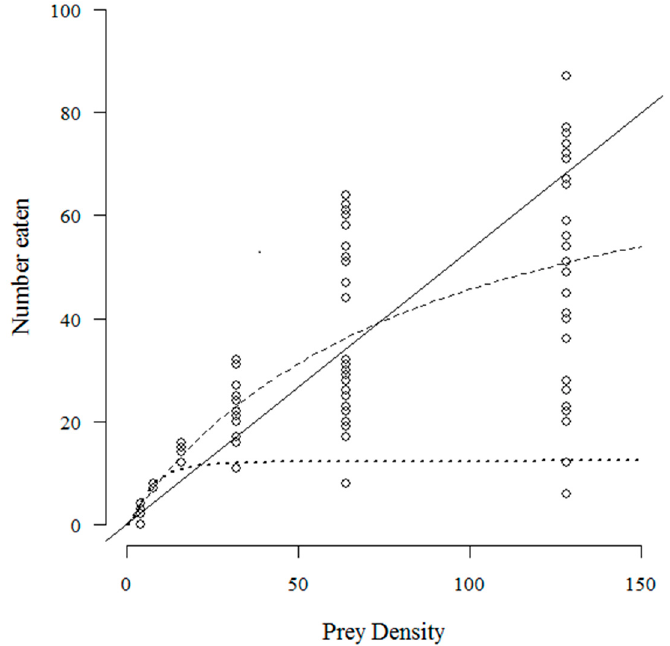
Figure 1. Number of T. absoluta eggs eaten during 24 h by the mirid predator C. infumatus when offered four, eight, 16, 32, 64 and 128 eggs. The dashed curve—a type II functional response—describes the data best. The drawn line represents the fit for a type I response, and the dotted curve for a type III response. The open circles represent the values found for each replicate; 25 replicates were performed for each prey density.